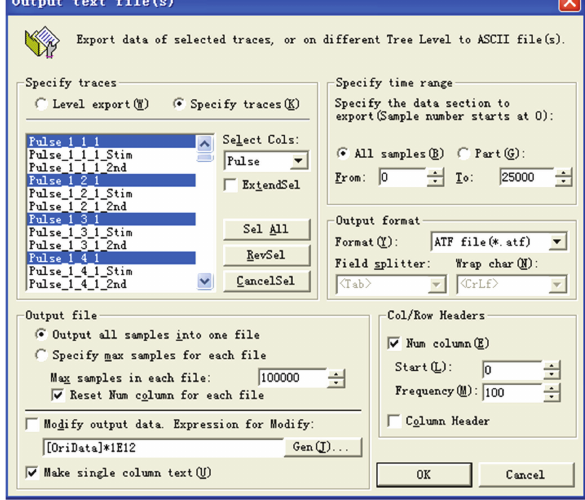
Figure 4: The data export